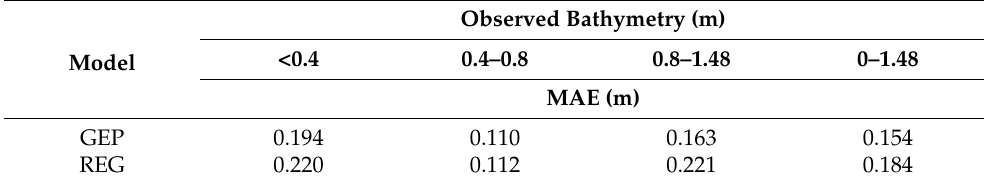
Table 5. MAE comparison for three depth ranges in the testing